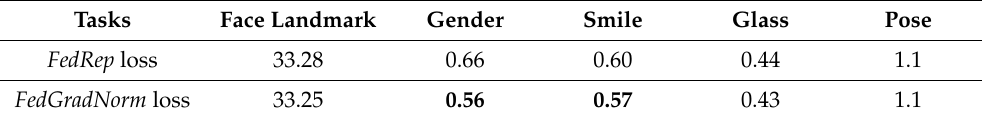
Table 4. Comparison of task losses after 100 epochs in FedGradNorm and FedRep ; imbalanced data allocation among